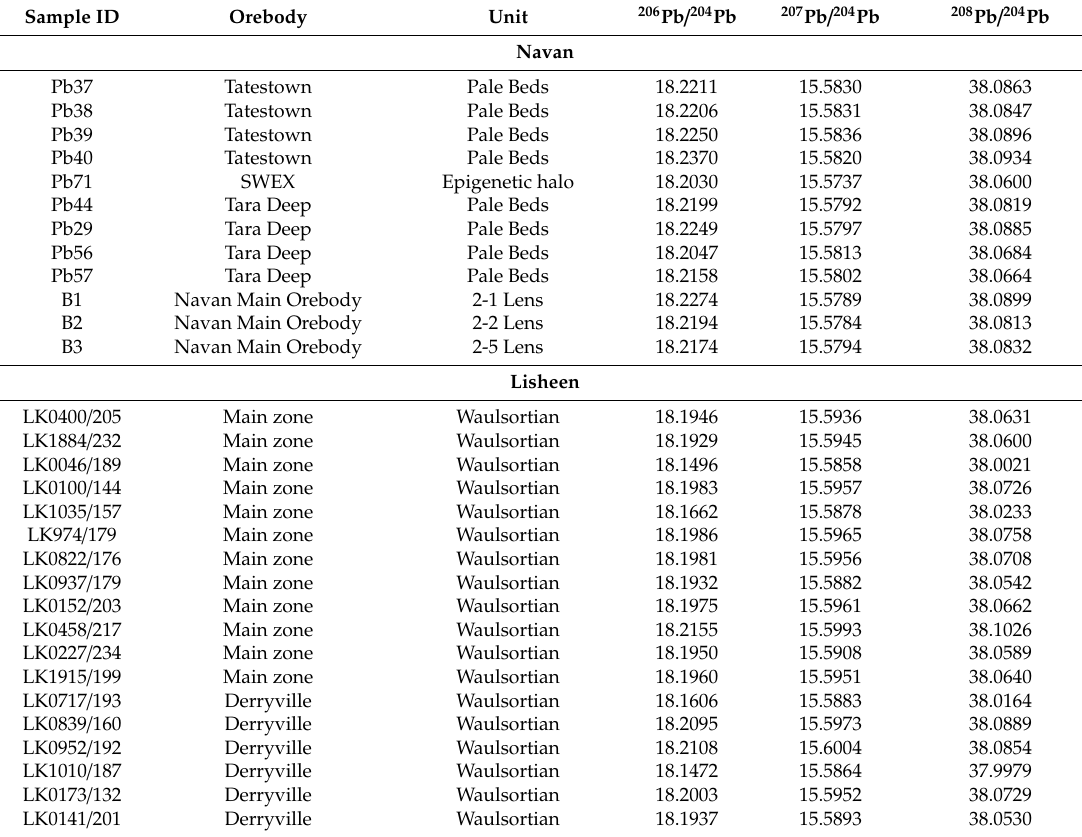
Table A3. Pb isotope composition from Navan and Lisheen